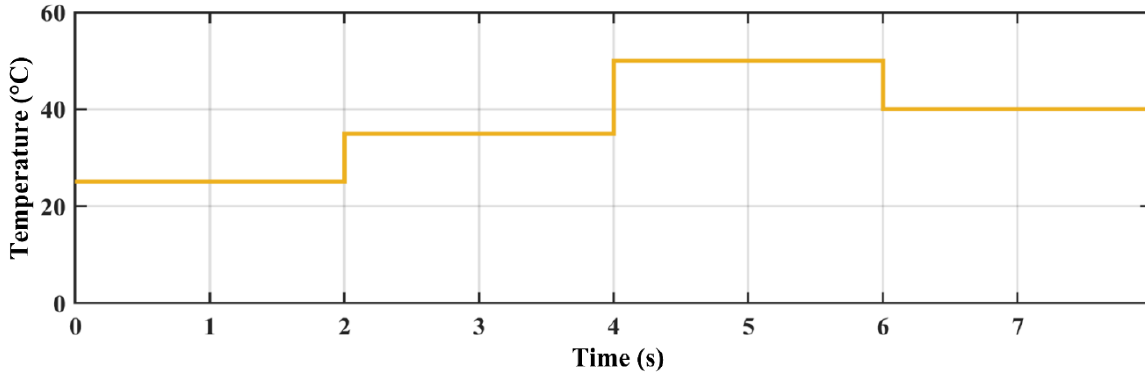
Figure 14. Change in cold-side temperature w.r.t time.